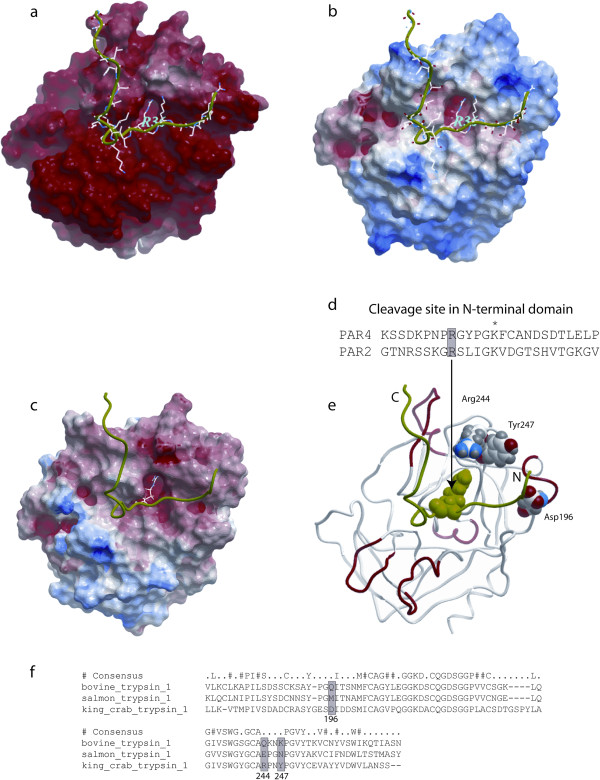
Molecular modelling of king crab, salmon, and bovine trypsin. a – c: Electrostatic surfaces of (A) king crab trypsin (homology model), (B) bovine trypsin (pdb code: 1s0r), and (C) Atlantic salmon trypsin (pdb code: 1hj8). The most electropositive potential is shown in blue, whereas the most electronegative potential is shown in red. The PAR-2 agonist peptide is displayed in green ribbon. d: The N-terminal fragment of PAR-4 and PAR-2, Arg at the cleavage site (shaded), *: a conserved positive charged residue in tethered peptides. e and f: The location of 3 binding site residues in the king crab trypsin model that corresponds to different residues in the bovine and Atlantic salmon trypsin (shaded boxes in the structural alignment). Asp196 in king crab trypsin corresponds to Met175 in Atlantic salmon and Gln155 in bovine trypsin; Arg244 in the king crab trypsin corresponds to Glu221 in Atlantic salmon and Gln199 in bovine trypsin; and Tyr247 in king crab trypsin corresponds to Asn224 in Atlantic salmon trypsin and to Lys202 in bovine trypsin.